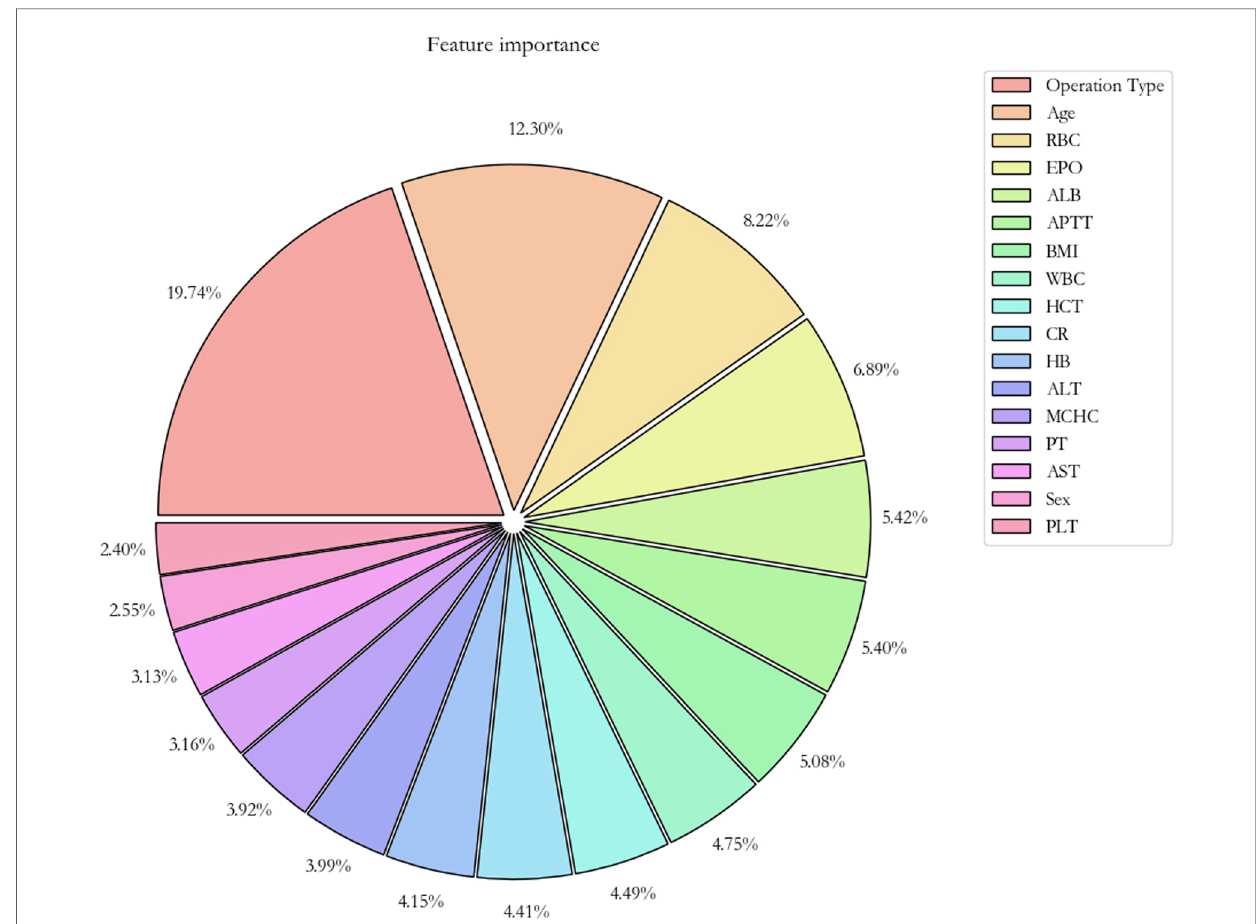
FIGURE 3 Importance of the features in the catBoost prediction model. The pie plot shows the relative importance of features for predicting the risk of postoperative RBC transfusion, sorted by importance from high to low. RBC, red blood cell count; EPO, erythropoietin use; ALB, albumin; APTT, activated partial thromboplastin time; WBC, white blood cell count; HCT, hematocrit; CR, creatinine; Hb, hemoglobin; ALT, alanine aminotransferase; MCHC, mean corpuscular hemoglobin concentration; PT, prothrombin time; AST, aspartate aminotransferase; PLT,